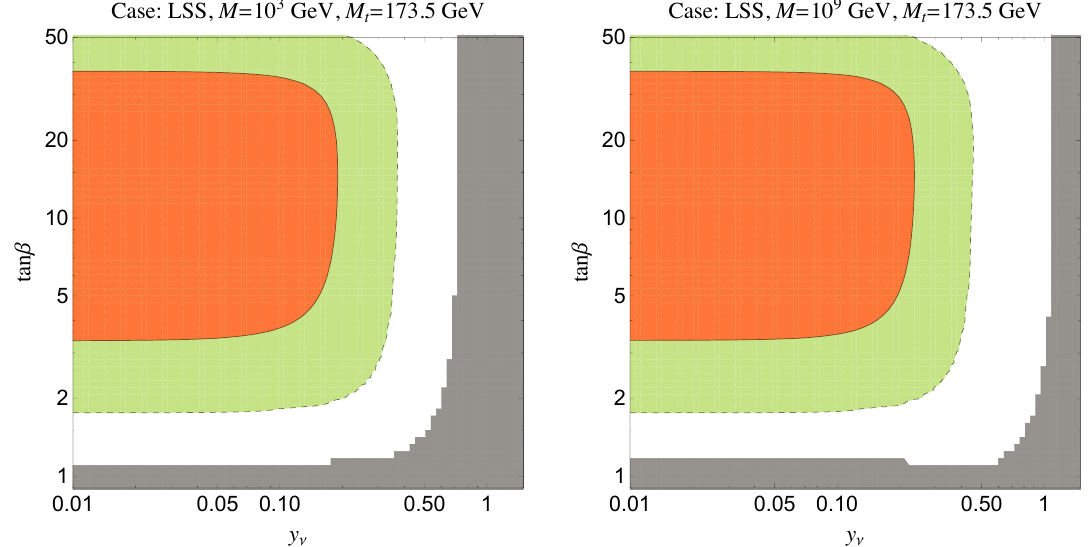
Figure 5 . The allowed values of tan (cid:12) by an absolute stability (unshaded) and metastability (green) of the scalar potential as function of y 1 = y 2 = y 3 (cid:17) y (cid:23) as de(cid:12)ned (and for M = 10 3 and 10 9 GeV) in eq. (2.10). The orange region corresponds to unstable scalar potential while the grey region in the bottom is where the perturbativity of the couplings is